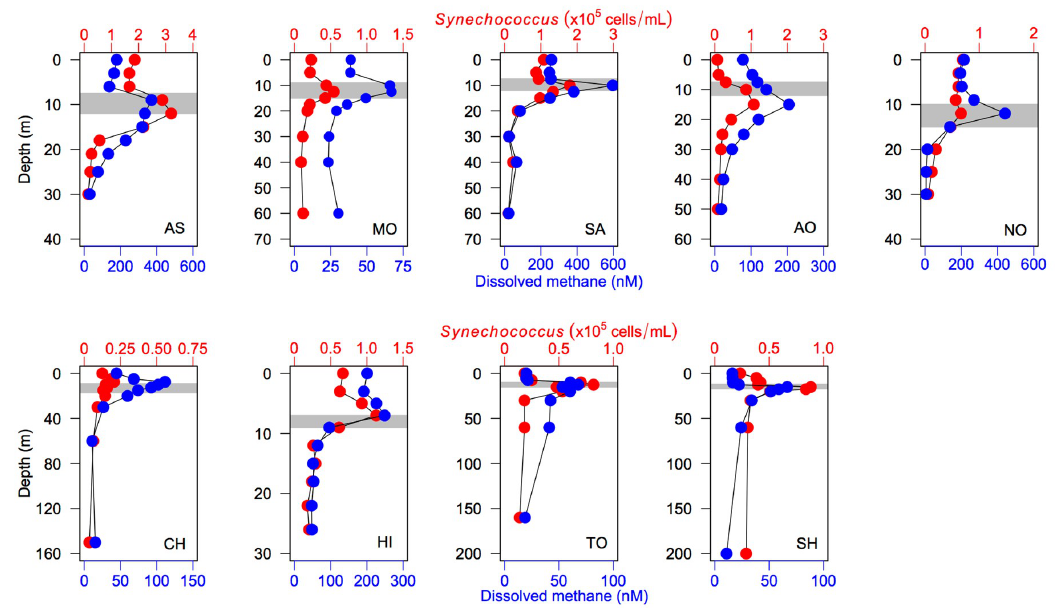
Figure 6. Vertical distribution of Synechococcus density (red circles) in relation to the dissolved CH 4 profile (blue circles) in the study lakes. Shaded areas denote the range of the thermocline.